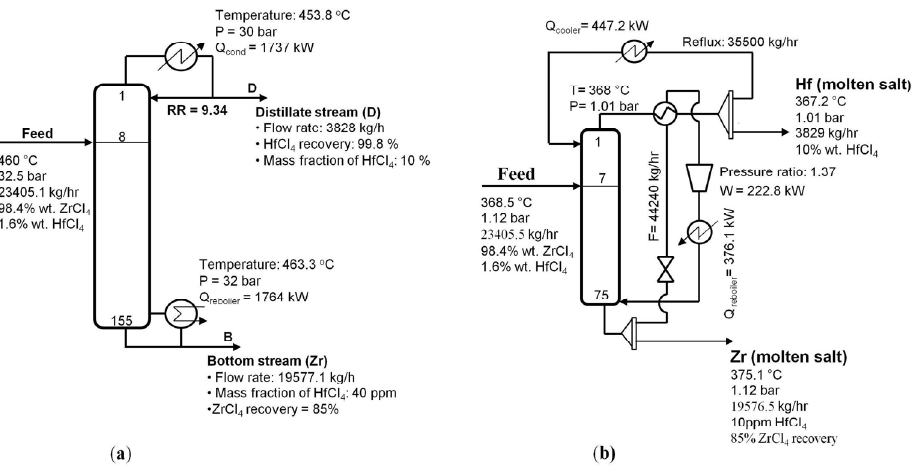
Figure 6. Schematic diagram of ( a ) conventional distillation [9] and ( b ) enhanced extractive distillation configuration using a partial bottom flashing heat